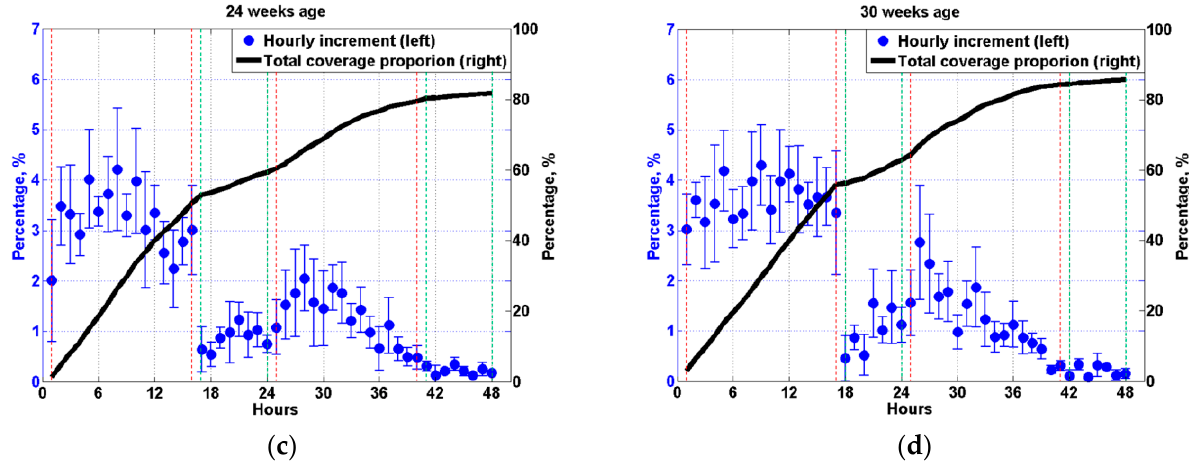
Figure 7. Hourly increment of manure coverage proportion (left Y -axis) and total coverage proportion (right Y -axis) on the pp plates measured in ( a ) 12 weeks age, ( b ) 18 weeks age, ( c ) 24 weeks age, and ( d ) 30 weeks age. Each test starts at 5 am (lights on) and lasts for 48 h with a measurement interval of one hour. Data between red-dash lines are measured at daytime (lights on), and data between green-dash lines are measured at nighttime (lights off).